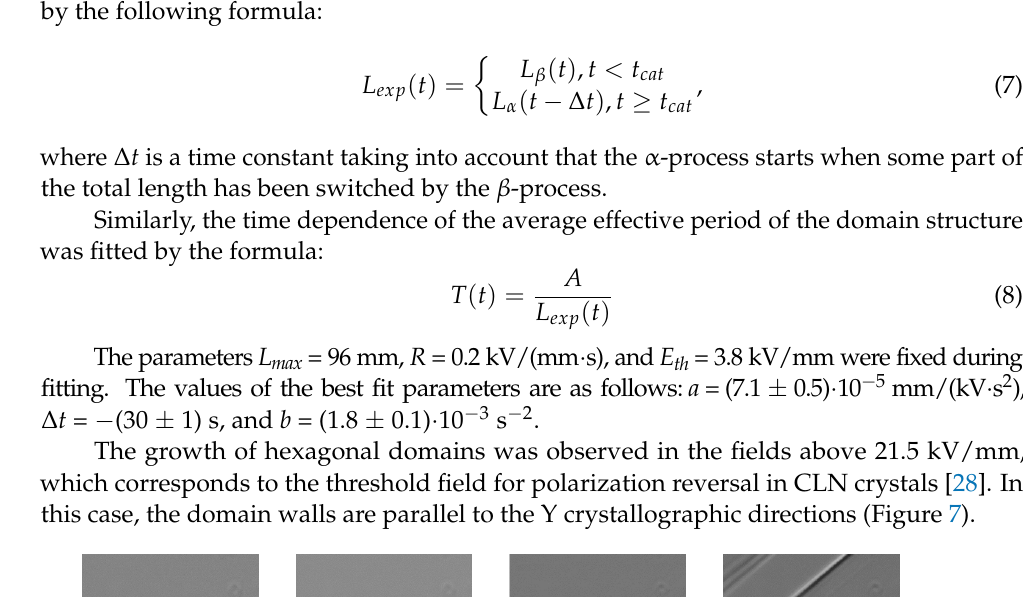
Figure 6. Time dependencies of the domain structure parameters during switching in increasing field: ( a ) the total length of the stripe domains and ( b ) the effective period of the domain structure, fitted by Equation (7) and Equation (8), respectively.